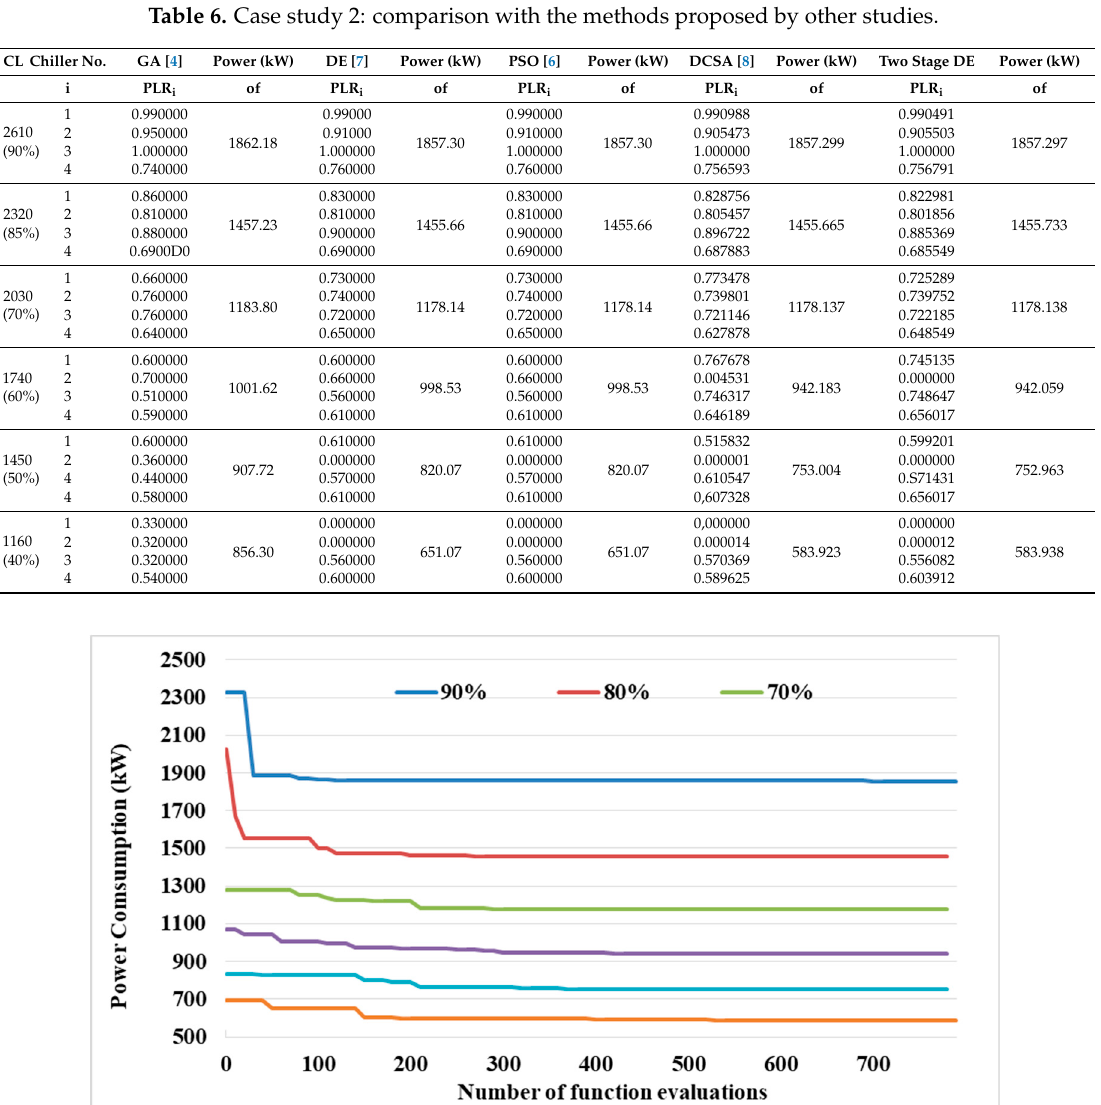
Figure 6. Convergence of two-stage DE for case study 1.